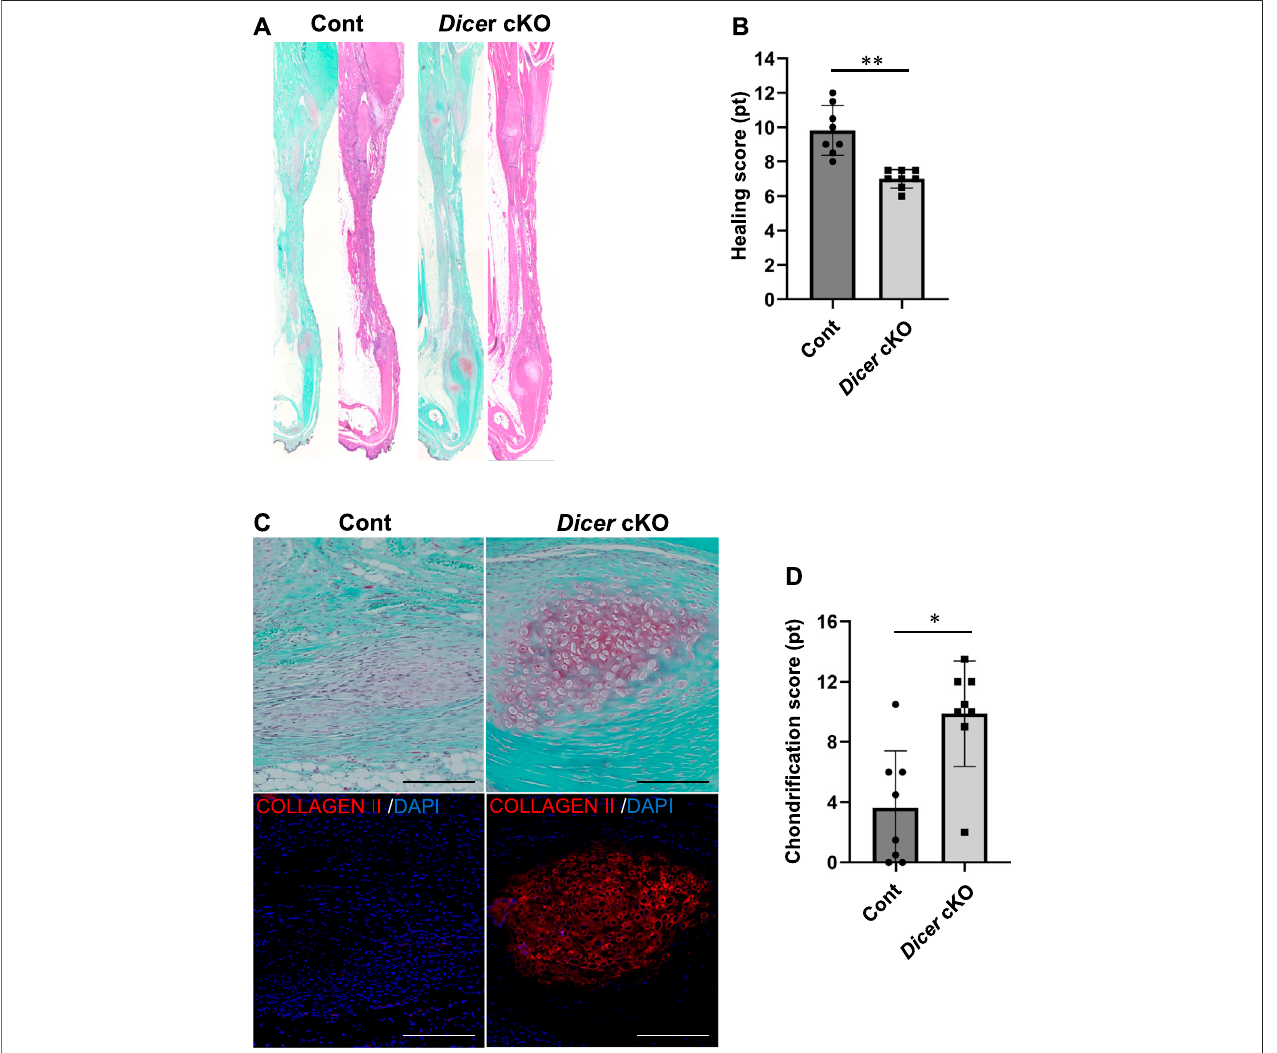
FIGURE 4 | Tendon healing in Dicer cKO mice. (A) Hematoxylin and Eosin (HE) staining ofAchilles tendons of Cont and Dicer cKO mice at 4 weeks after injury. (B) Tendon healing scores were signi fi cantly decreased in Dicer cKO mice compared with Cont mice. (C) Chondri fi cation parts with Safranin O- and type II COLLAGEN- positivewere more frequently observed in Dicer cKO mice during healing. Scalebars: 200 µm. (D) Chondri fi cation scoreswere signi fi cantlyincreasedin Dicer cKO mice compared with Cont mice. n = 8 mice for each genotype. Data are represented as mean ± S.D. Comparison of mean values was performed using Welch ’ s t